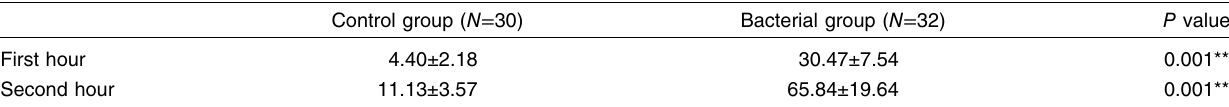
Table 13 Comparison between mean values of ESR (first and second hour) in the bacterial group relative to the control group Control group ( N = 30) Bacterial group ( N = 32) P value First hour